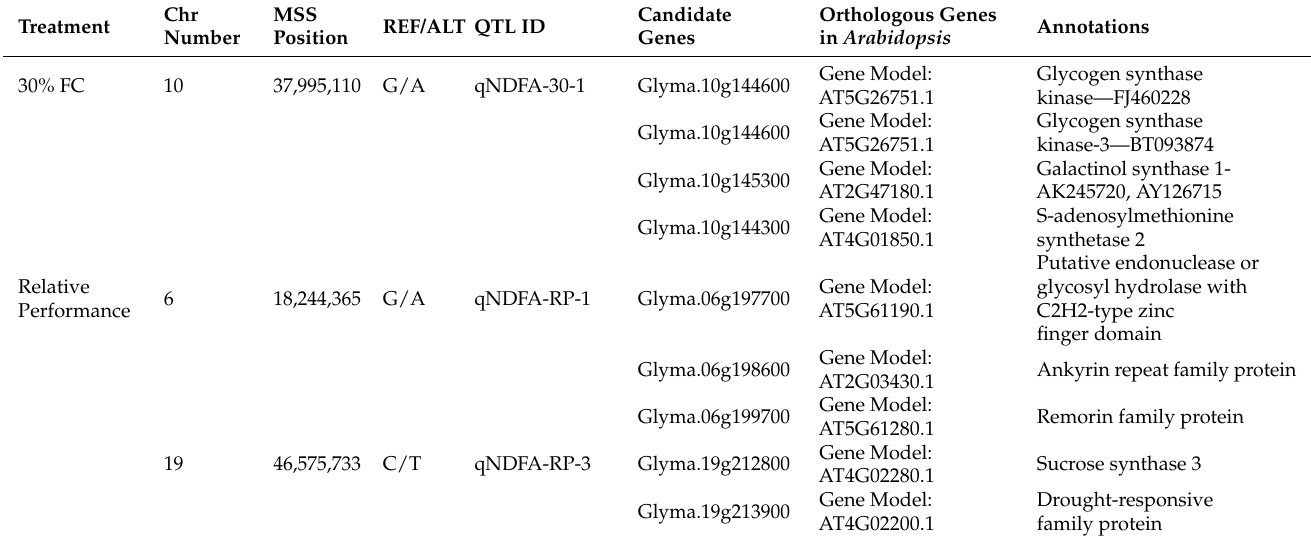
Table 2. Candidate genes associated with drought stress (30% field capacity) and relative